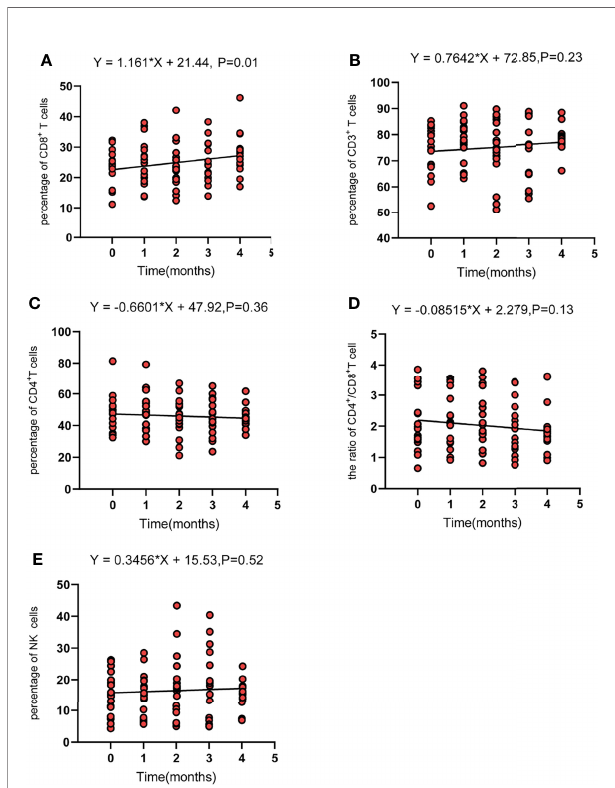
FIGURE 2 | The dynamic change of CD8 T cells (CD3 + CD8 + ) (A) , total T cells (CD3 + ) (B) , CD4 T cells (CD3 + CD4 + ) (C) , the CD4 + /CD8 + ratio (D) , and NK cells (CD3 - CD16 + CD56 + ) (E) . Fit a line with simple linear regression. p < 0.05 indicates slope deviation from